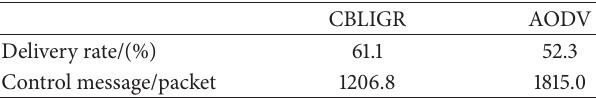
Table 4: Compare with